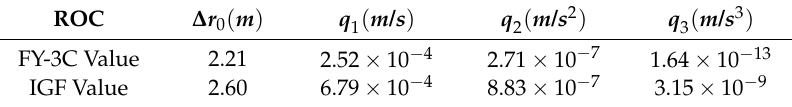
Table 1. Tropospheric delay of each order of time ROC in GEO SAR